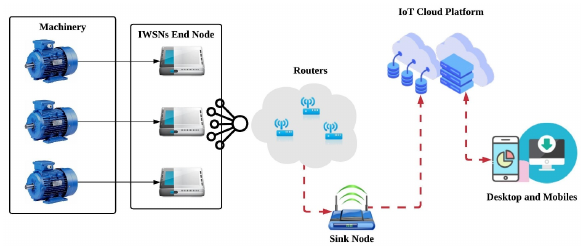
Figure 1: Proposed design of fault diagnosis system